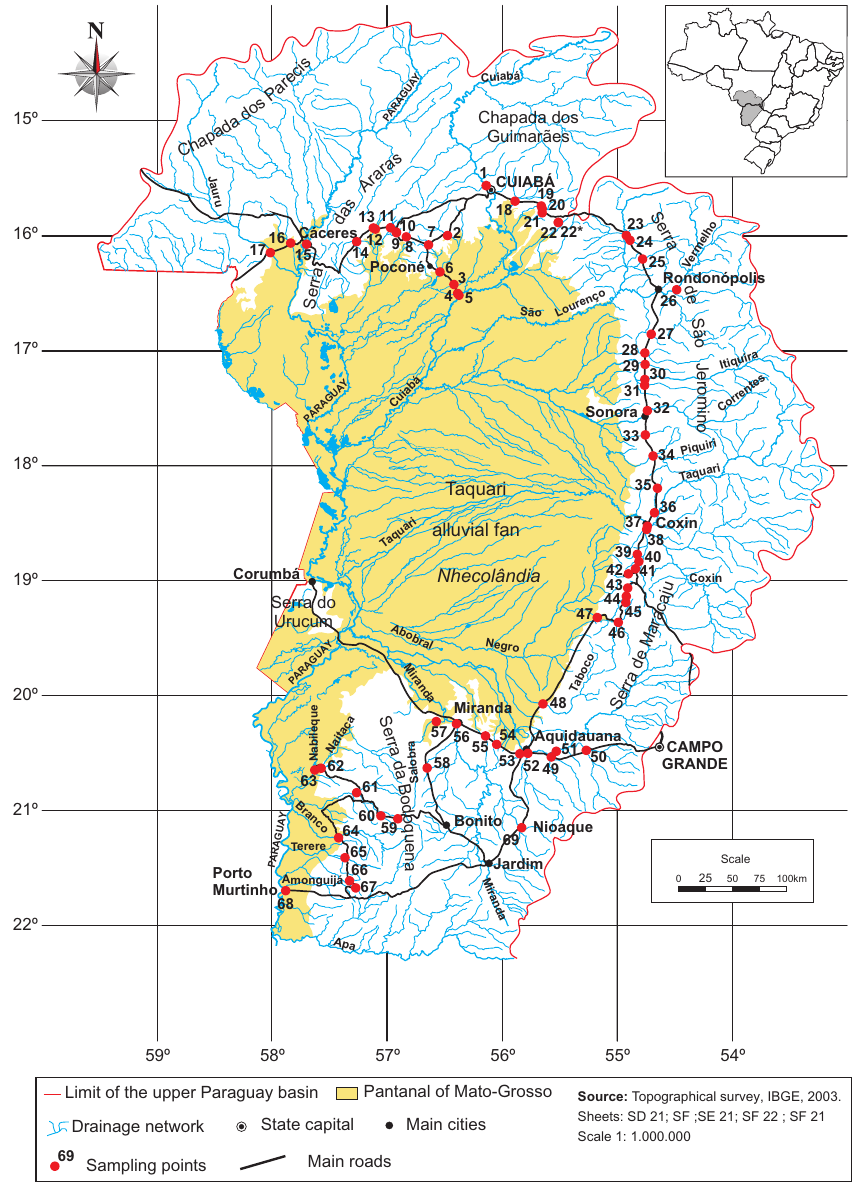
Fig. 1. The Upper Paraguay Basin, the Pantanal wetland and the Nhecolˆandia sub-region. Location of the sampling points DS and WS.